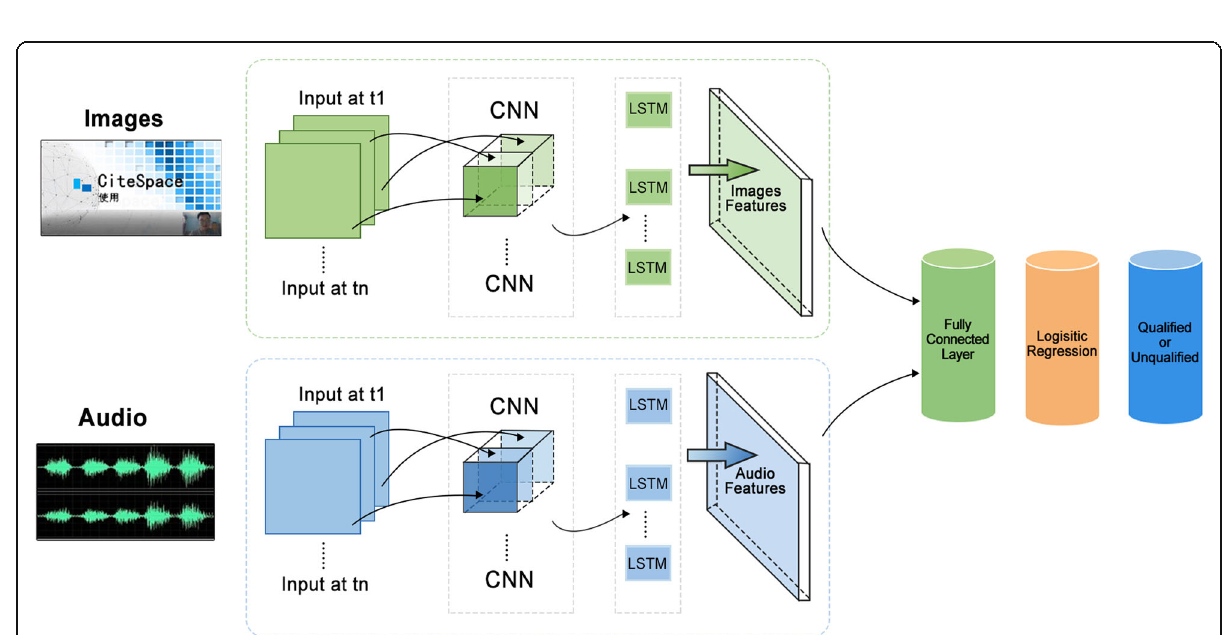
Fig. 2 The architecture of the multi-channel CNN-LSTM